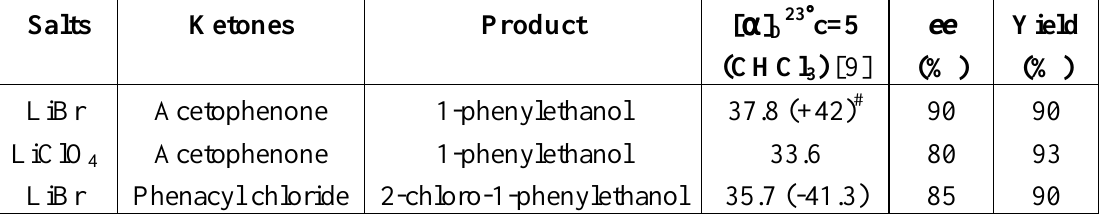
Table 2: Reduction of ketones in presence of lithium salts at room temperature (30 °